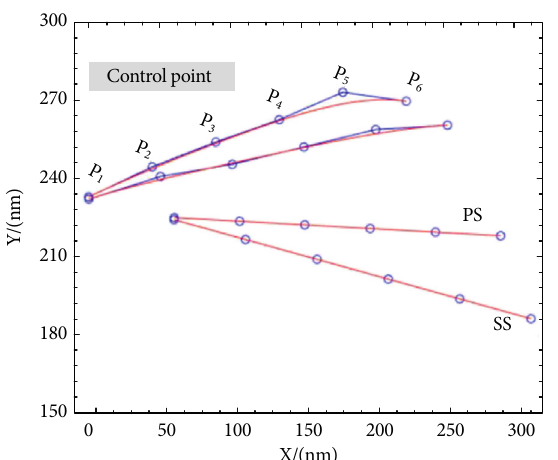
Figure 7: 2D parametric modelling of di ff user.